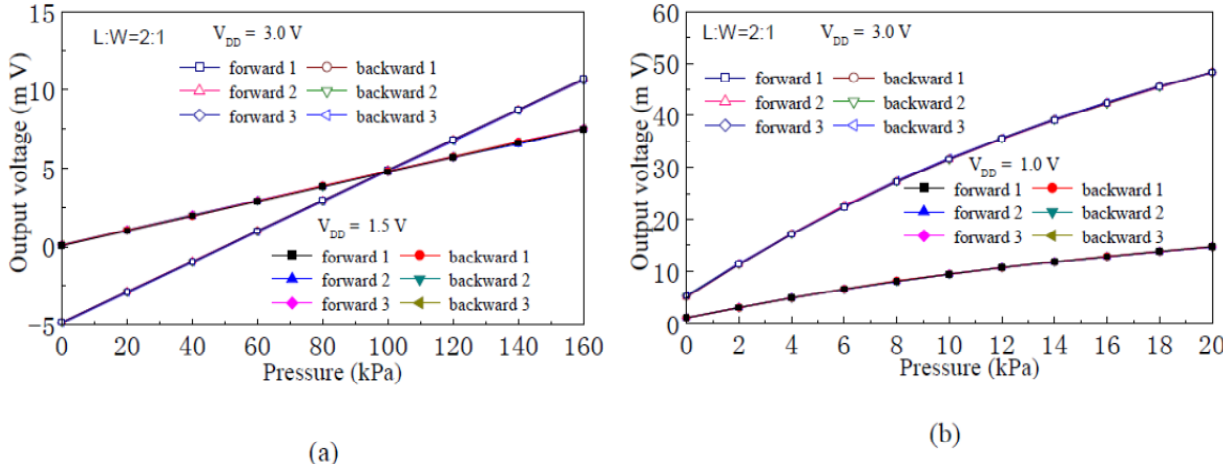
Figure 9. Repeatability experimental curves of the nc-Si/c-Si heterojunction MOSFETs pressure sensor. ( a ) Membrane thickness 75 μ m; ( b ) Membrane thickness 45 μ m.